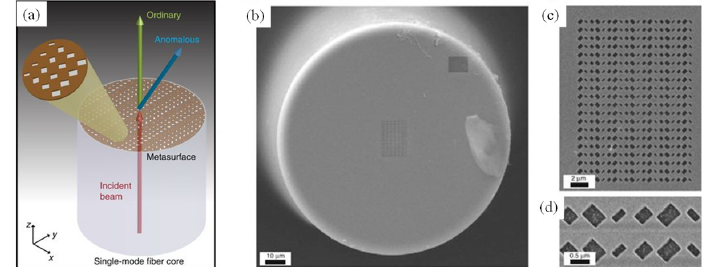
Figure 6. ( a ) Schematic representation of an optical fiber metatip. A plasmonic metasurface is fabricated on the optical fiber end facet. The metasurface displays a linear-phase profile at the wavefront of a given component of an impinging beam. As a result, the transmitted beam is split into an ordinary (copolarized) component propagating in the incidence direction and an anomalous an angle. ( b ) SEM image of a fabricated sample with the entire fiber cross-section shown. ( c , d )